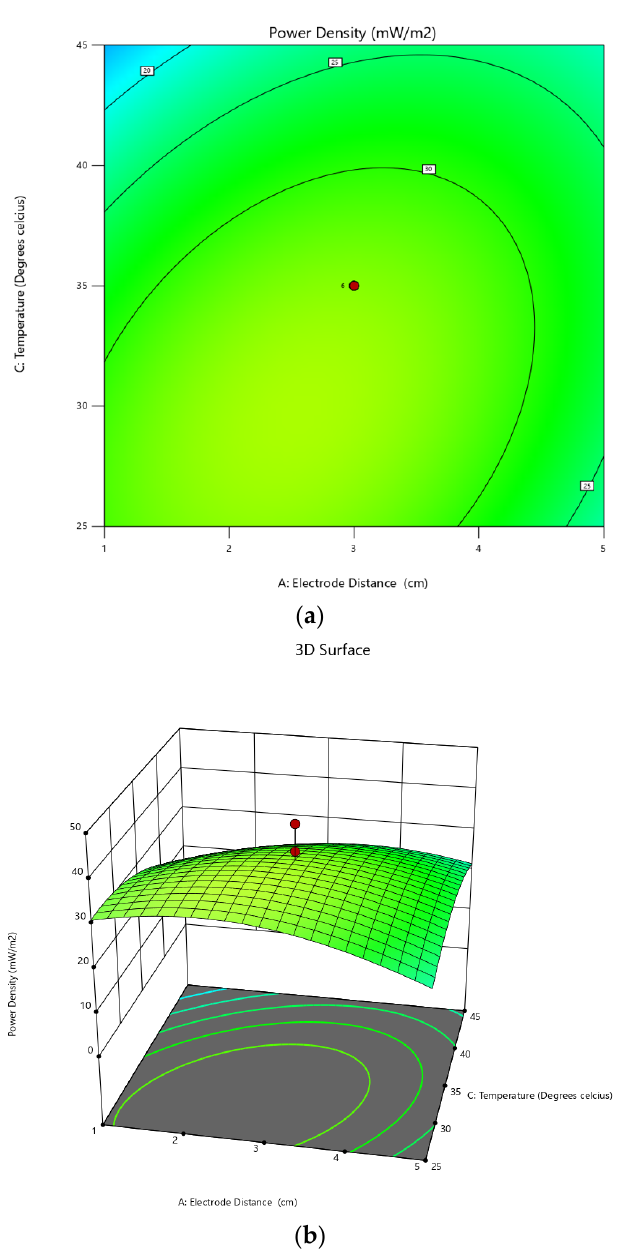
Figure 11. ( a ) Contour plot and ( b ) response surface plot of power density generation as a function of temperature relative to electrode distance.